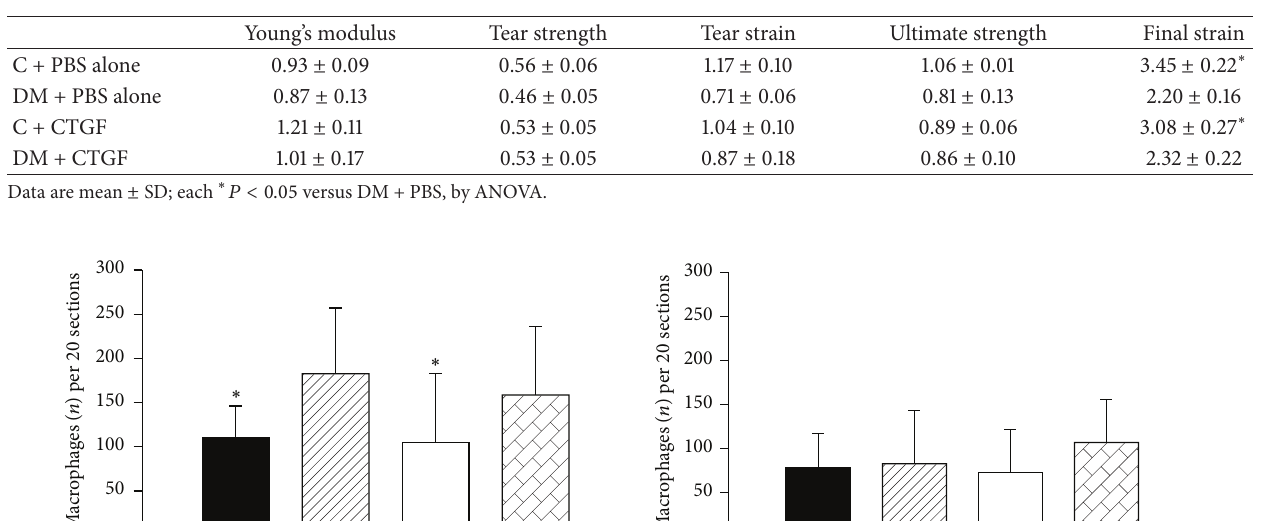
Table 2: Wound breaking strength data in all groups.